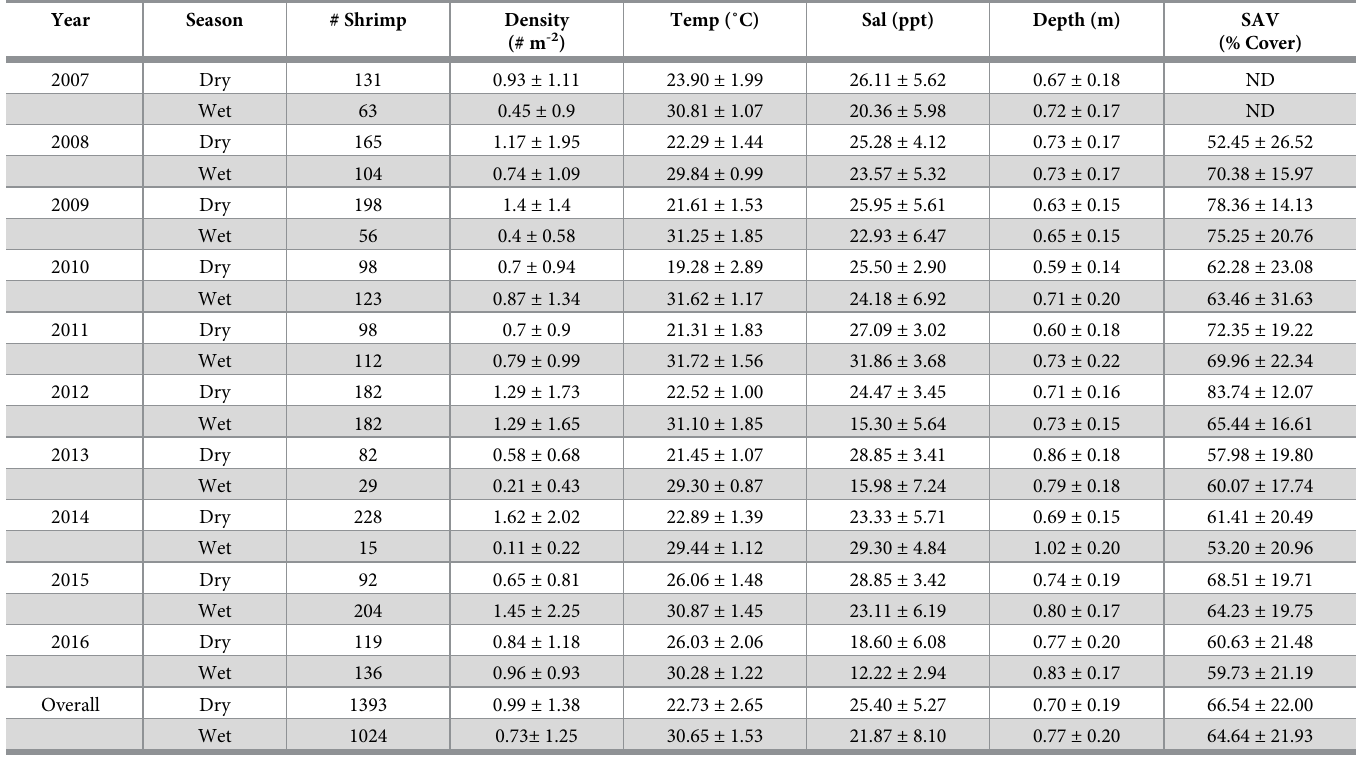
Table 1. Number of pink shrimp collected, average pink shrimp density ( ± SD), and average ( ± SD) of water quality and habitat attributes for survey